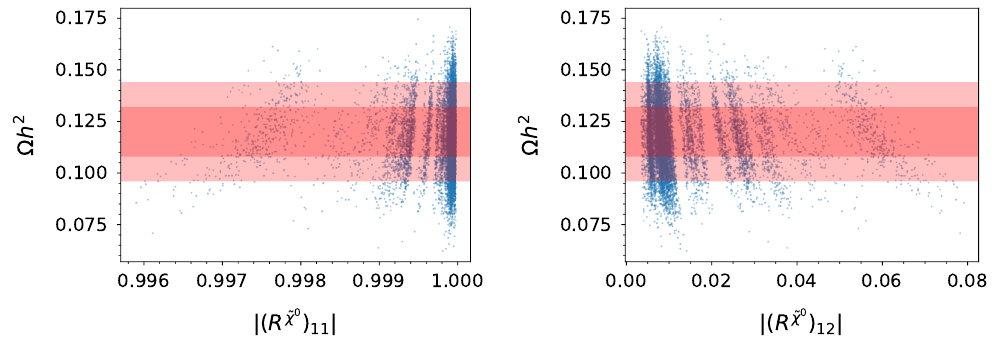
Figure 12 . The bino ( | ( R ˜ χ 0 ) 11 | , left) and wino ( | ( R ˜ χ 0 ) 12 | , right) contents of the lightest neutrino shown against the corresponding dark matter relic density. The higgsino contents of the lightest neutralino are negligible and not shown here. The neutralino mixing matrix R ˜ χ 0 is defined according to the SLHA standard [64]. The red (light red) region is indicating the 1 σ ( 2 σ ) limits.